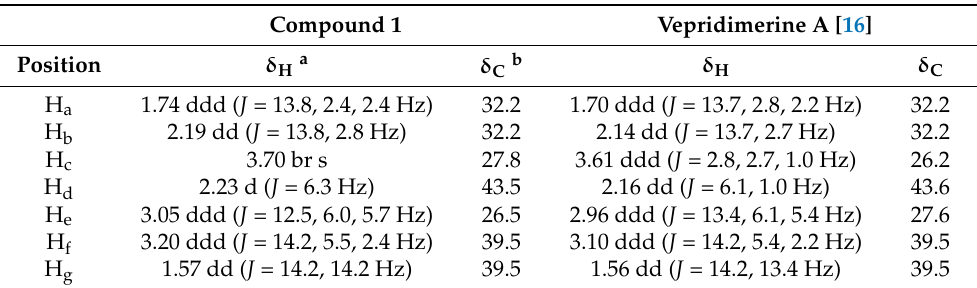
Table 2. Comparison with the signals (H a -H g and 13 C NMR) of the previously known vepridimerine A and compound 1